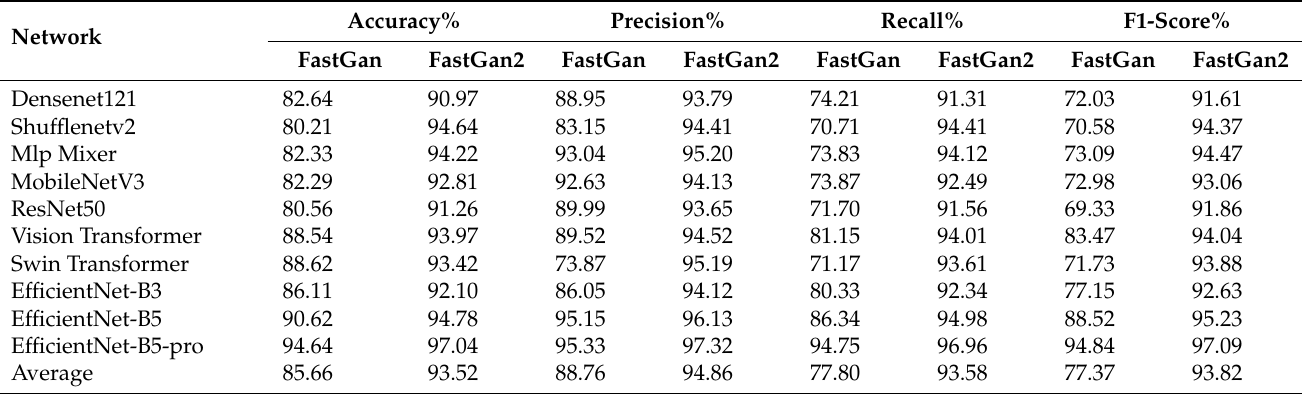
Table 3. Performance comparison of ten kinds of classification networks.